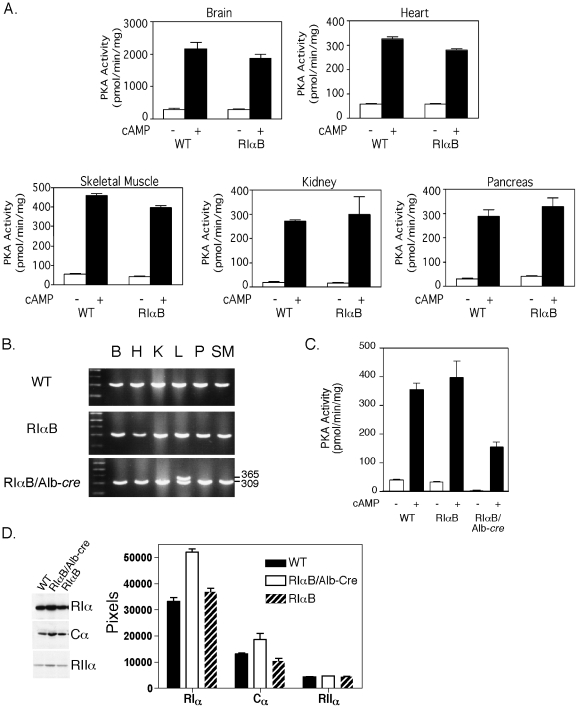
Cre-mediated activation of RIαB allele specifically in the liver decreases PKA activity in vivo.
A, Kinase assay on tissue homogenates from WT and RIαB mice measured in the absence (basal) or presence (total) of 5 µΜ cAMP using kemptide as the substrate. Non-PKA specific activity was measured in the presence of PKI and subtracted from basal and total values. Data values are represented as mean ± SEM; n = 3 animals per group. B, Representative PCR analysis of genomic DNA of brain (B), heart (H), kidney (K), liver (L) pancreas (P) and skeletal muscle (SM) were examined for Cre-mediated recombination of the RIαB allele in WT, RIαB and RIαB/Alb-cre mice. A 309 bp fragment indicates WT RIα, whereas a 365 bp fragment indicates the recombined mutant RIα allele, which was restricted to the liver. C, Kinase assay on liver homogenates from WT, RIαB, and RIαB/Alb-cre measured in the absence (basal) or presence (total) of 5 µΜ cAMP using Kemptide as the substrate. Non-PKA specific activity was measured in the presence of PKI and subtracted from basal and total values. Data values are represented as mean ± SEM; n = 3 animals per group. D, Representative western analysis and quantitation of pixel density on film exposures from WT, RIαB/Alb-Cre and RIαB mouse liver extracts. Data values in bar graph are represented as mean ± SEM. n = 4 replicates.